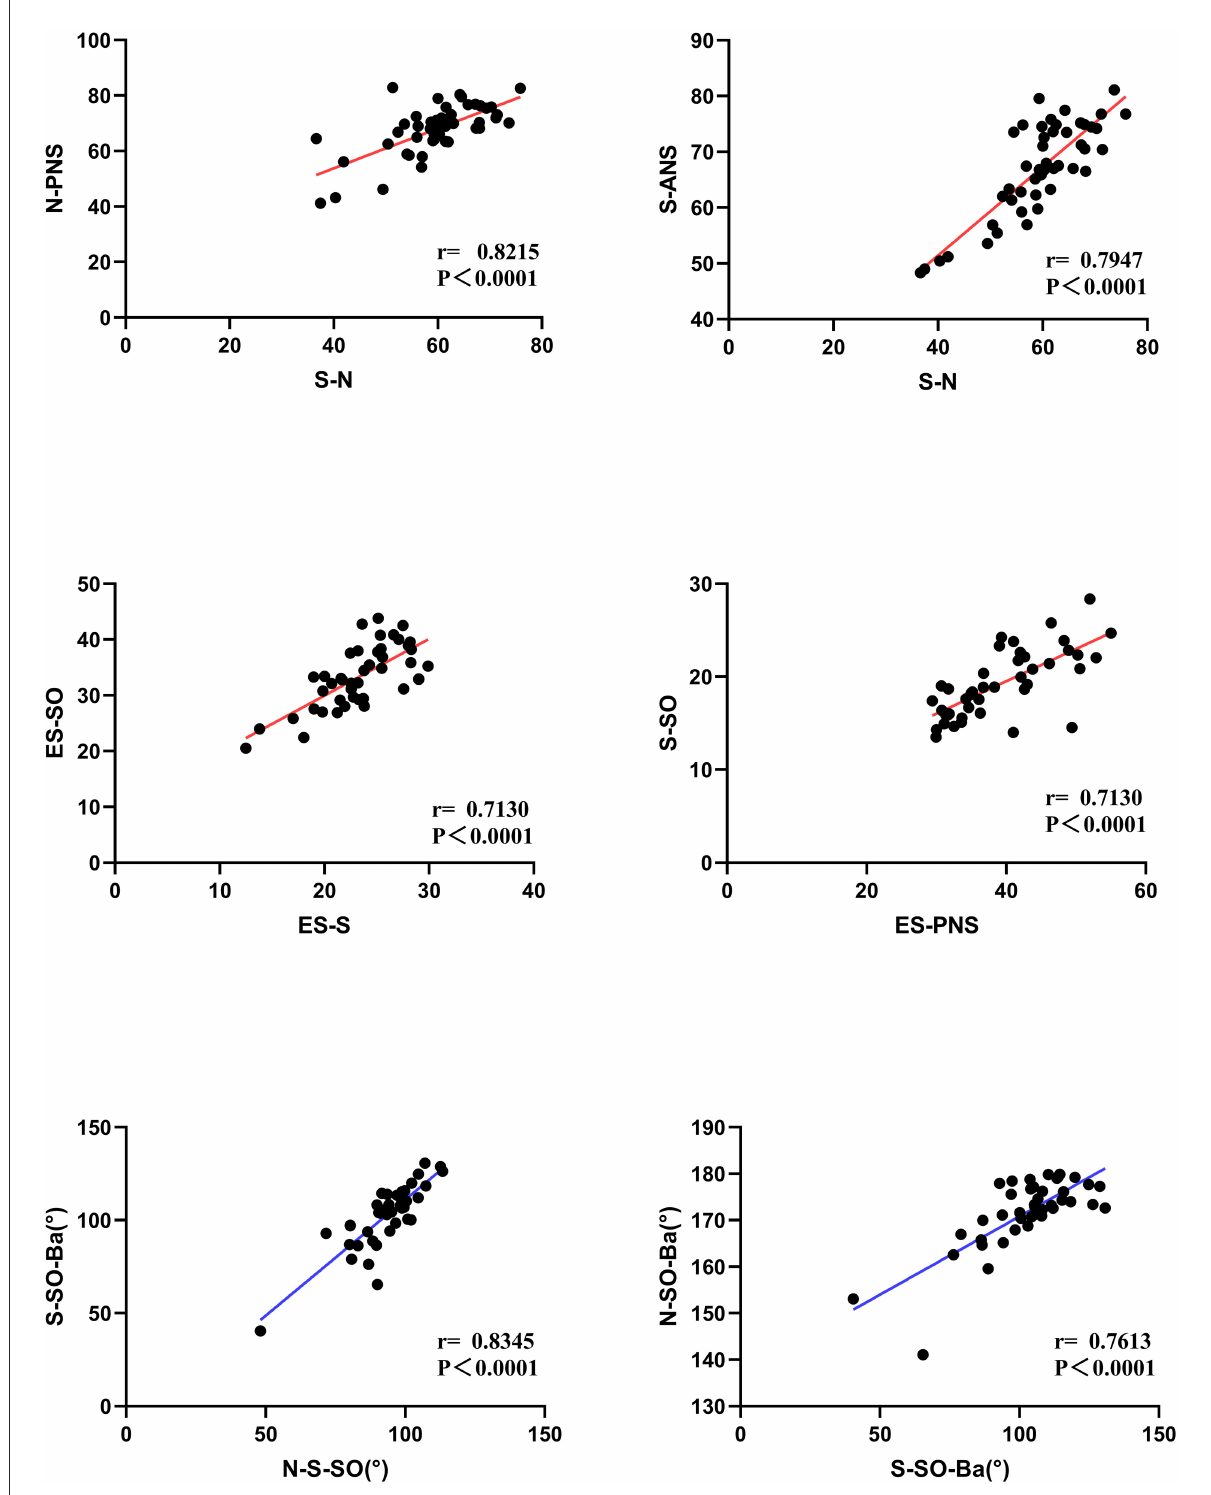
FIGURE8 The correlation analysis of distances and